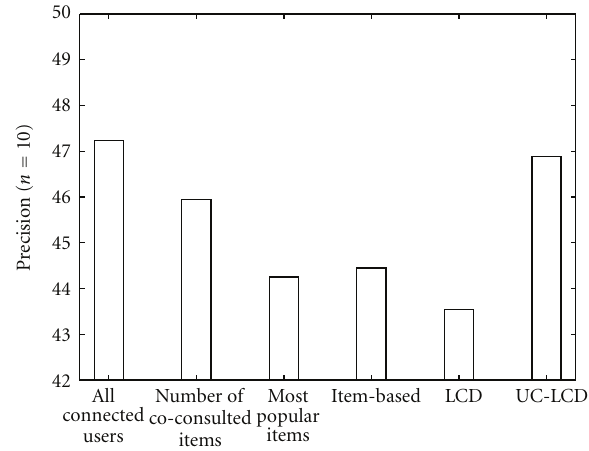
Table 2: Settingup of the communities of the Jester